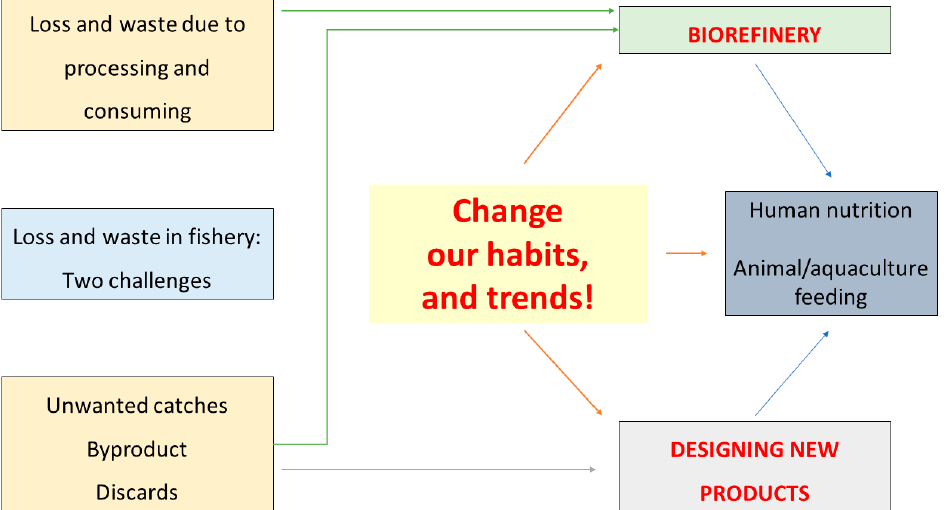
Figure 1. The figure describes the two threats beyond this paper along with the possible methods (biorefinery and production of new foods for human consumption and animal feeding).